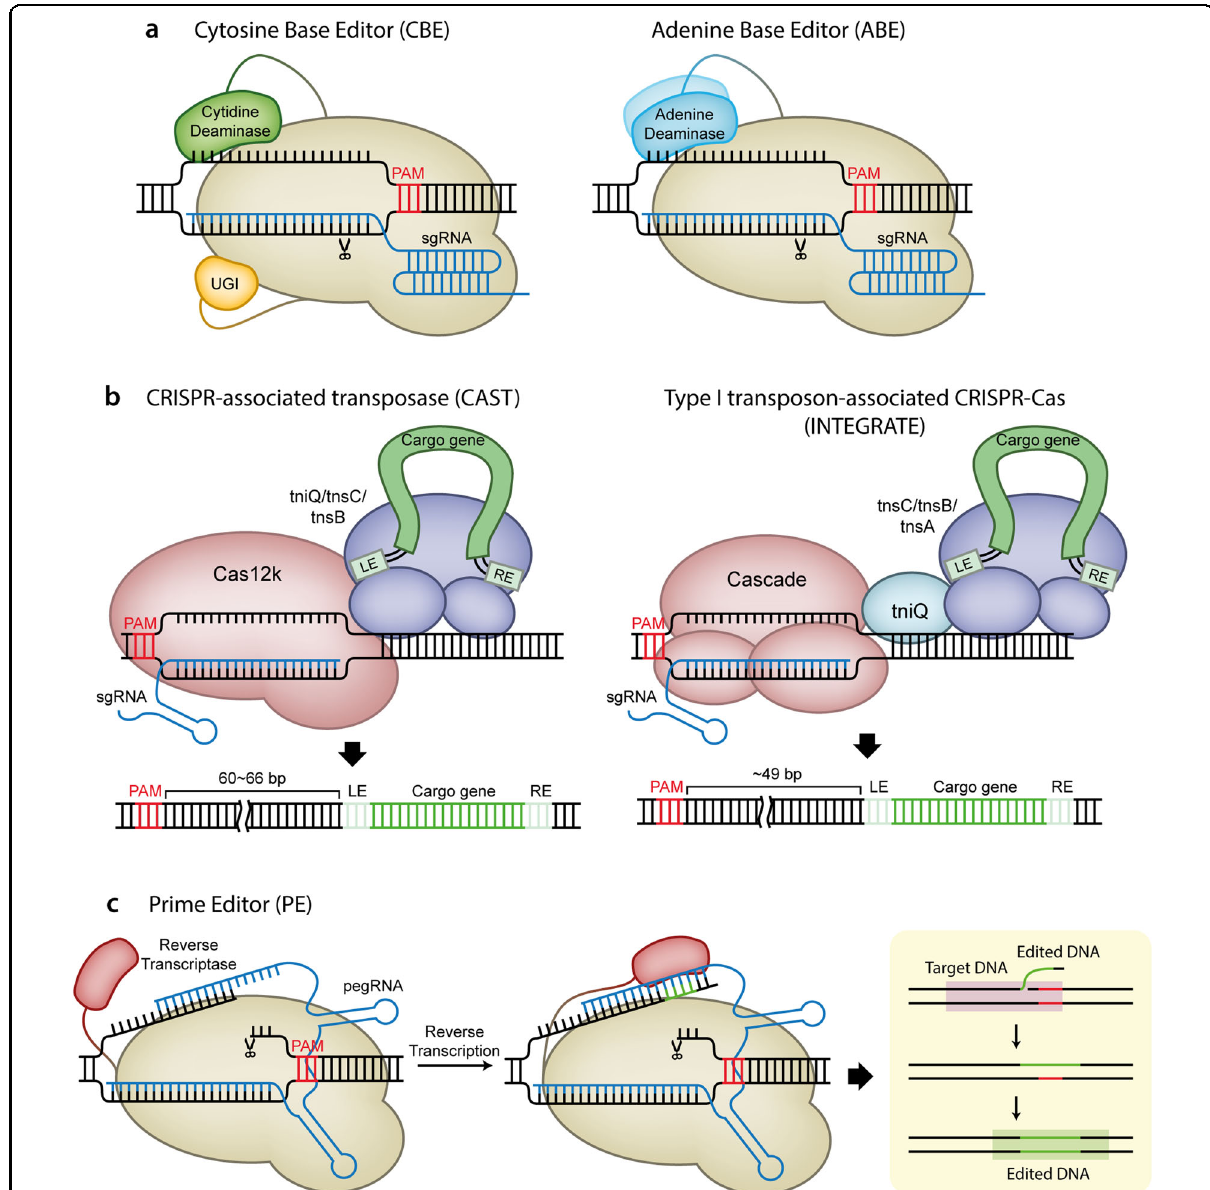
Fig. 4 Gene recovery strategies in the absence of DNA DSB generation. a Schematic of a cytosine base editor (CBE), an adenine base editor (ABE). b Schematic of the insertion of transposable elements by guide RNA-assisted targeting (INTEGRATE) with a type I transposon-associated CRISPR-Cas system and of RNA-guided DNA insertion with a CRISPR-associated transposase (CAST). LE transposon left end, RE transposon right end. c Schematic of a prime editor (PE) and its working mechanism. Reverse transcriptases in PEs copy the information in the pegRNAs into DNA target